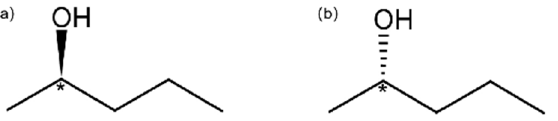
Figure 1. ( a ) (R) -2-Pentanol (CAS No. 31087-44-2), ( b ) (S) -2-Pentanol (CAS No. 26184-62-3).